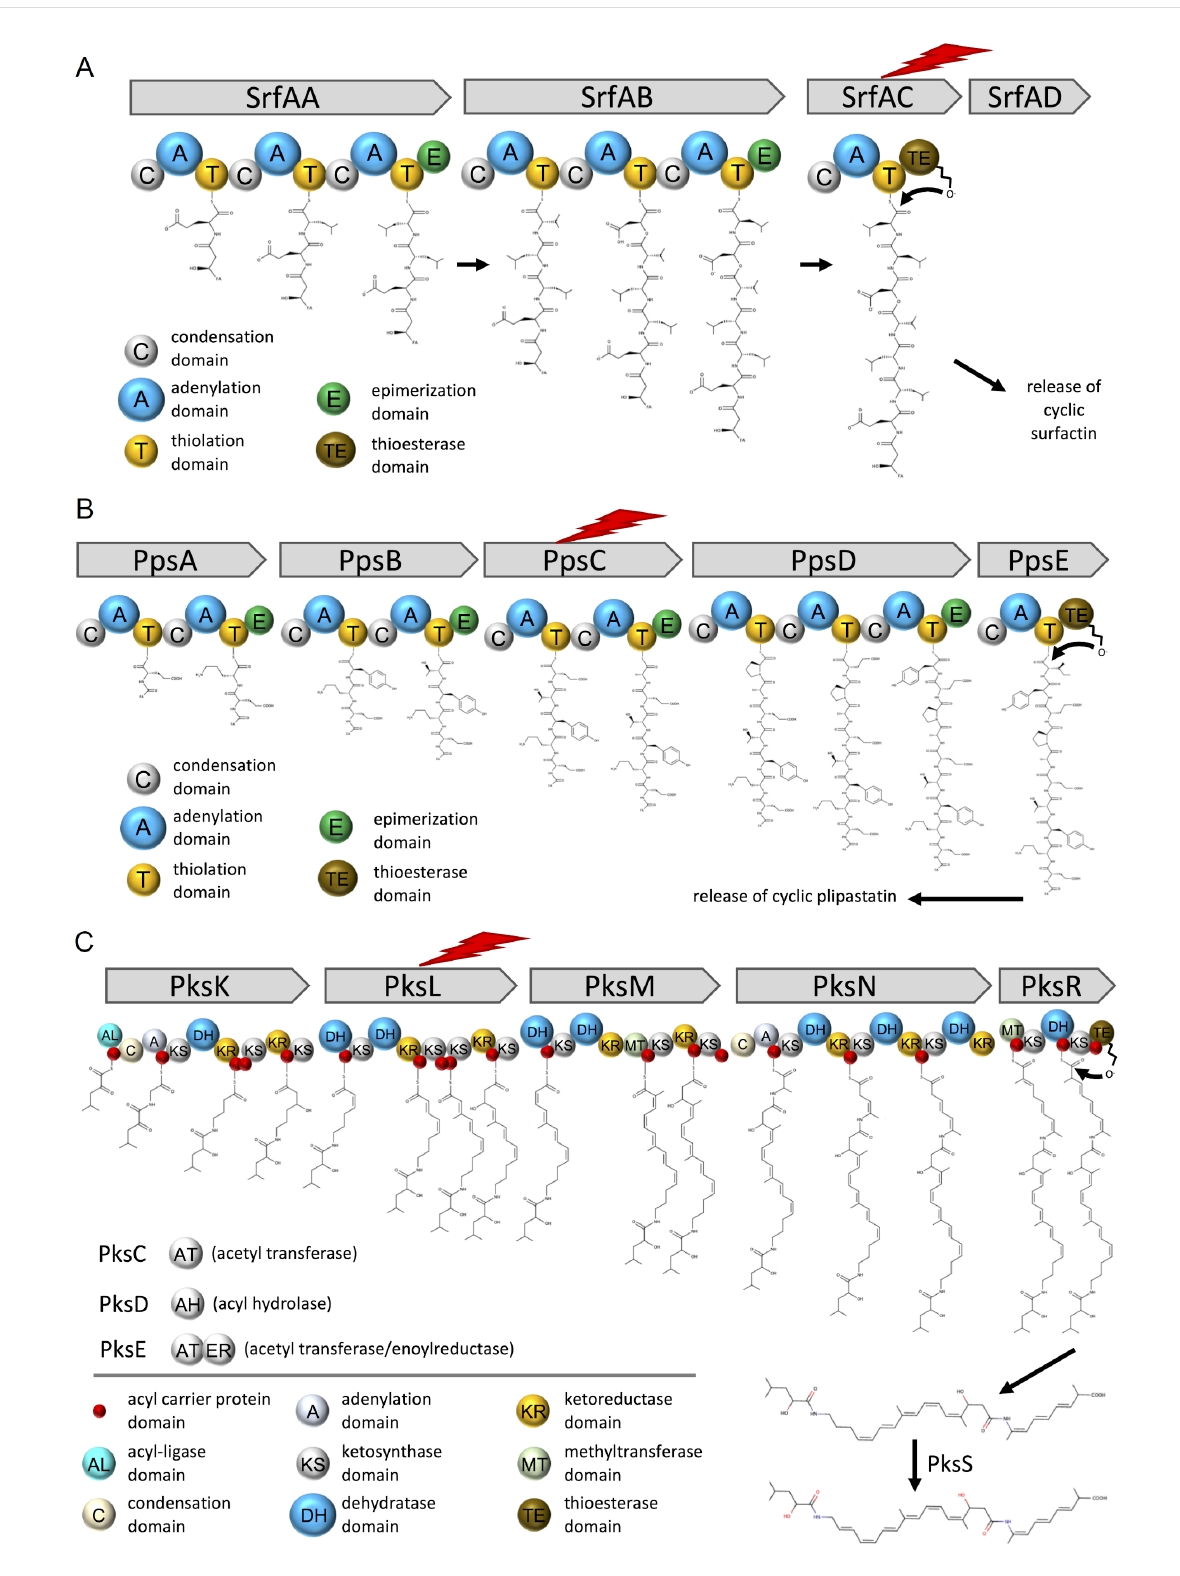
Figure 9: Overview on the biosynthetic pathways of surfactin (A), plipastatin (B), and bacillaene (C) produced by B. subtilis . The lightning bolt indi- cates the proteins for which the corresponding coding genes were deleted in the mutant